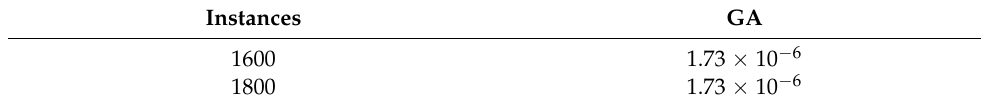
Table 9. The Wilcoxon rank-sum test results.